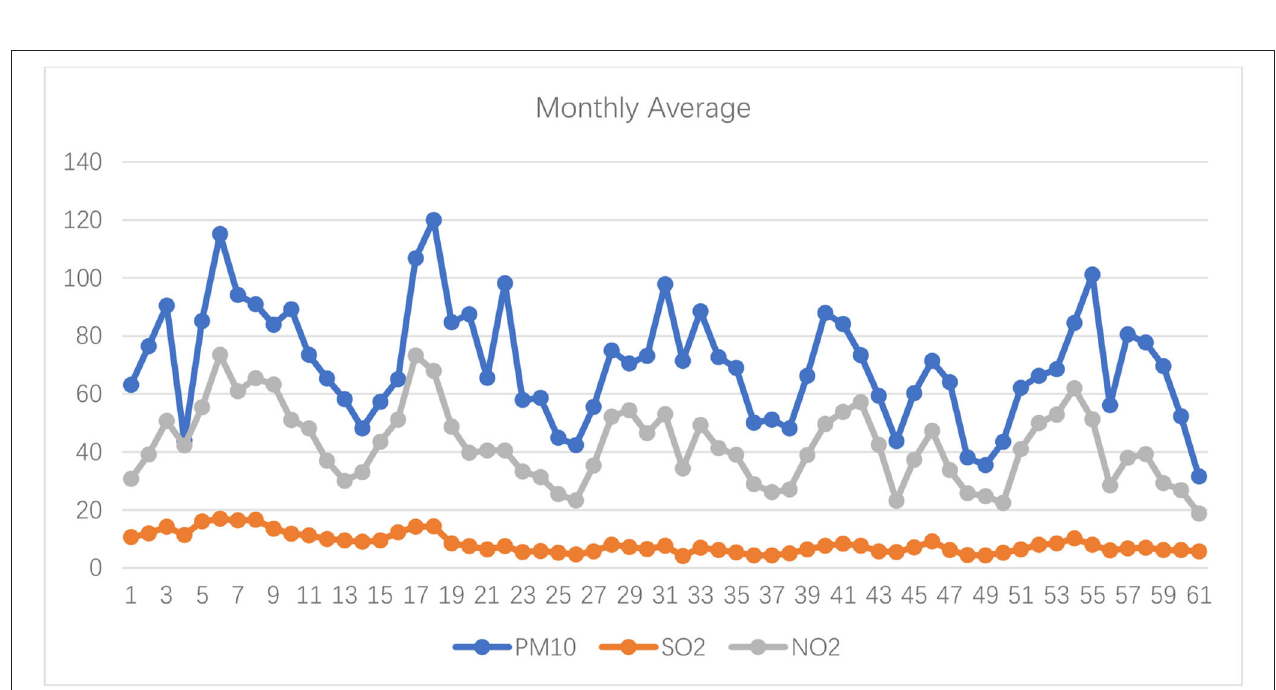
FIGURE 5 | Monthly average of PM10, SO 2 , and NO 2 of Hefei from July 2016 to July 2021 ( µ g/m 3 ).